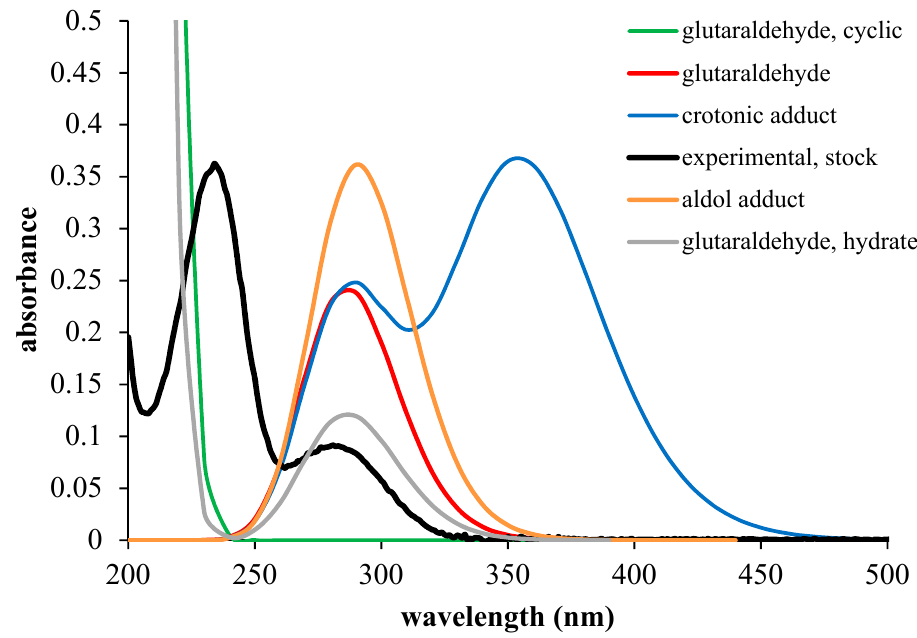
Figure 6. Comparison of the UV-VIS spectra of GA solutions, with spectra computed for GA and for a number of its reaction products.